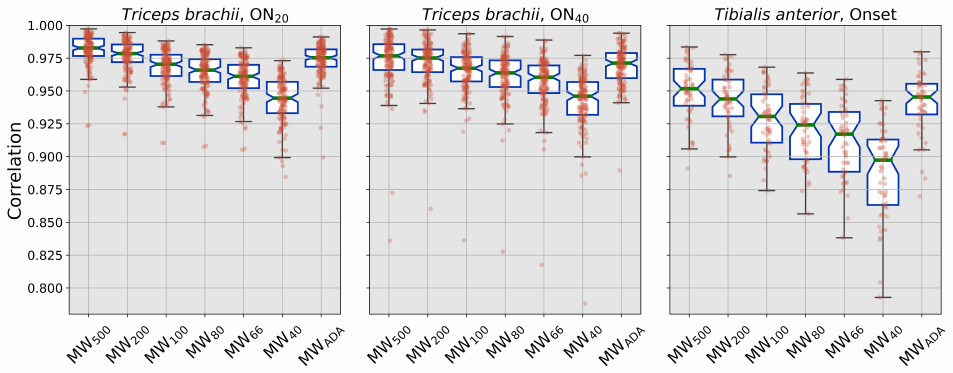
Figure 6. Correlation values. Colors have the same meaning as in Figure